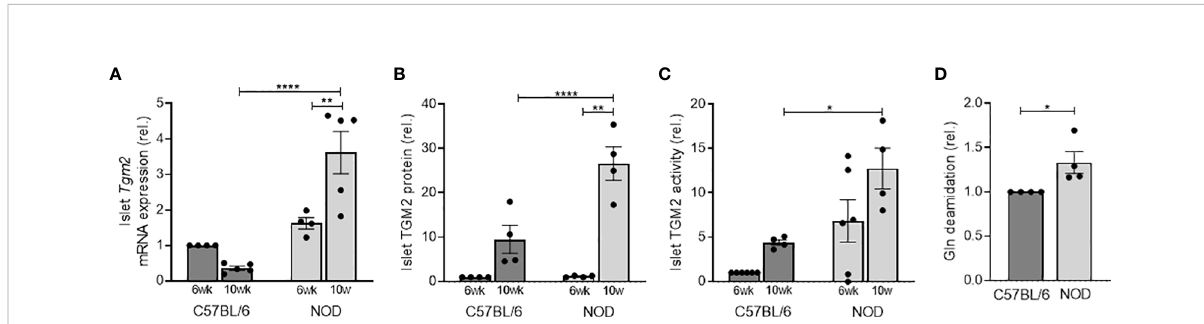
FIGURE 2 NOD mice have higher Tgm2 RNA levels and activity in islets of Langerhans compared to C57BL/6 mice. Tgm2 mRNA (A) , TGM2 protein levels (B) and activity (C) in islets of Langerhans of 6- and 10-week-old C57BL/6 and NOD mice. (D) Gln deamidation levels in islets of Langerhans of 10-week-old C57BL/6 and NOD mice, detected with LC-MS/MS. Data are shown as mean with SEM. One-way ANOVA with correction for multiple testing (A – C) and unpaired t-test (D) , *p<0.05, **p<0.01 and